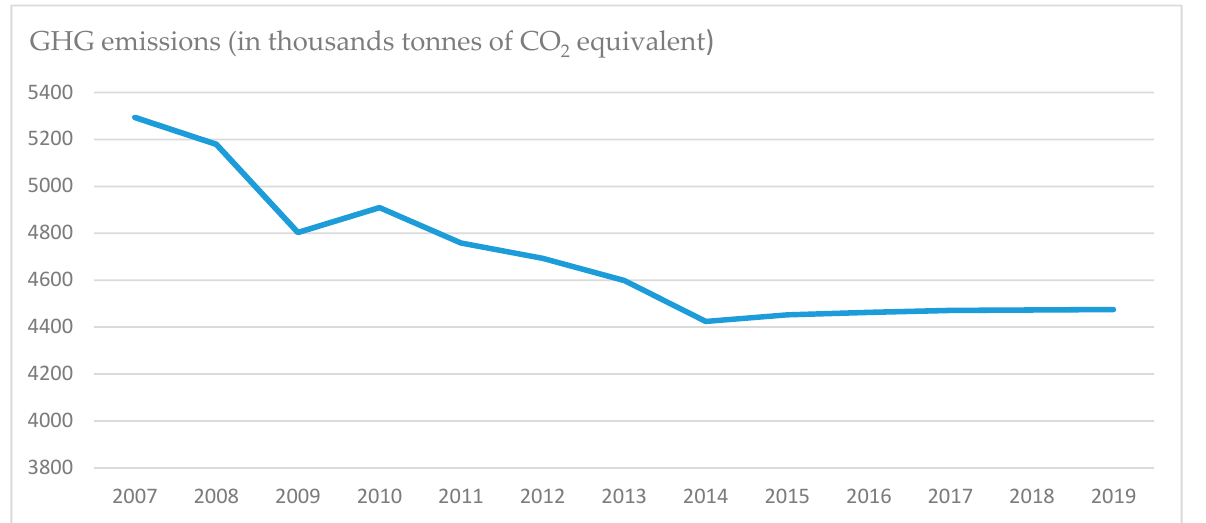
2 equivalent in the EU-28 countries